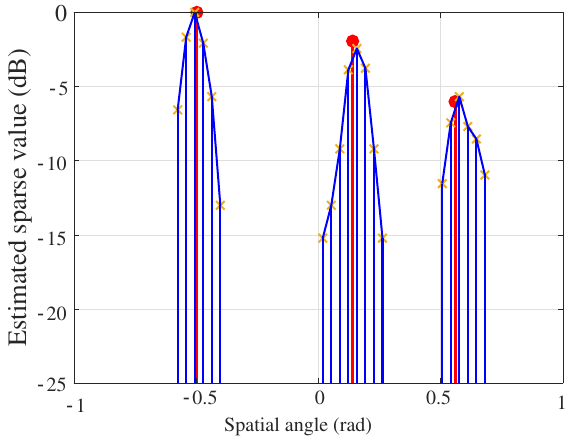
Figure 14. The reconstructed sparse signal with different power using AtomicNet and 2-bit ADC, where the red line denotes the ground-truth DOA, and the blue line denotes the estimated spa- tial